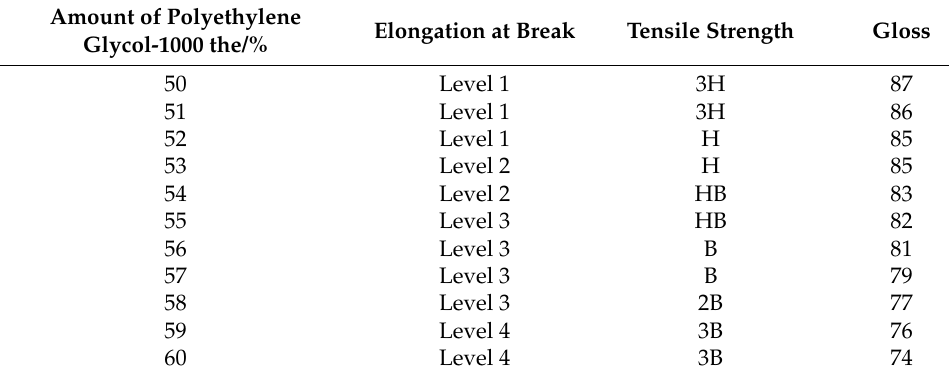
Table 3. Effect of amount of polyethylene glycol-1000 on the hardness and adhesion. Amount of Polyethylene